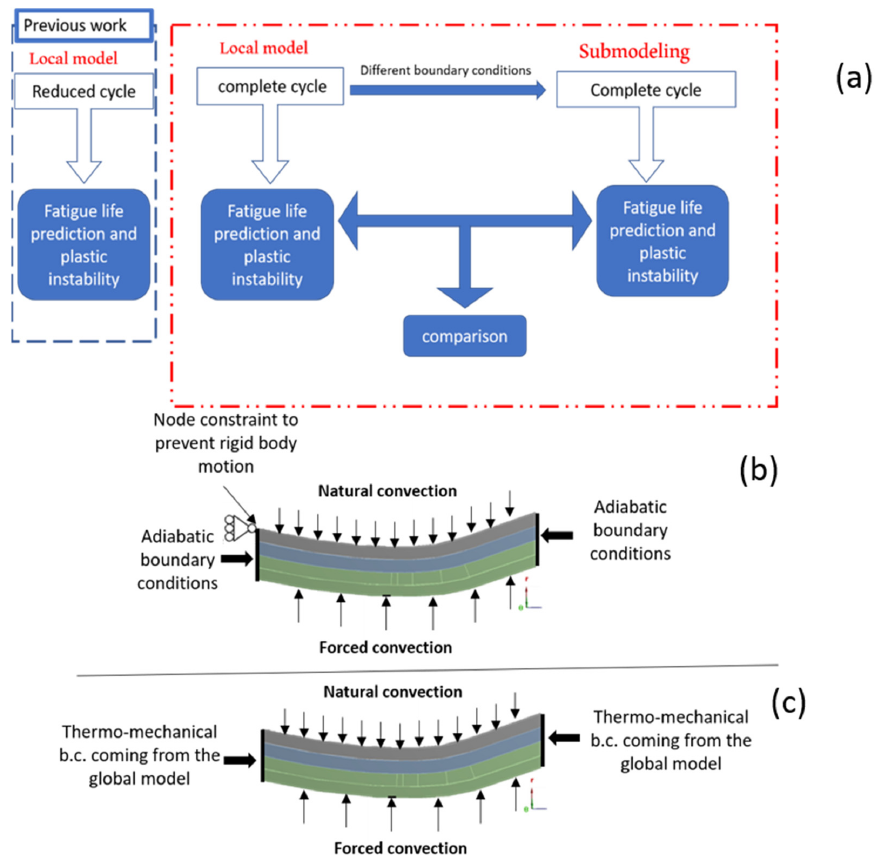
Figure 2. ( a ) Schematic representation of the modelling strategy; ( b ) local model boundary conditions; ( c ) sub-modelling boundary conditions.